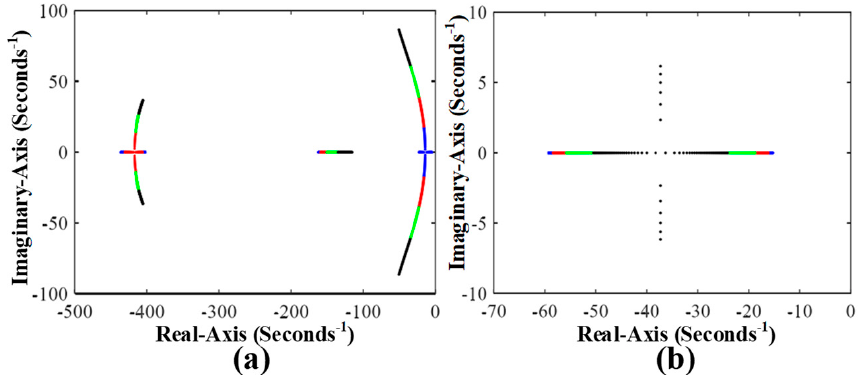
Figure 5. Pole distribution of different speeds under rated speed: ( a ) pole distribution diagram of motor before design; ( b ) pole distribution diagram of motor after design.